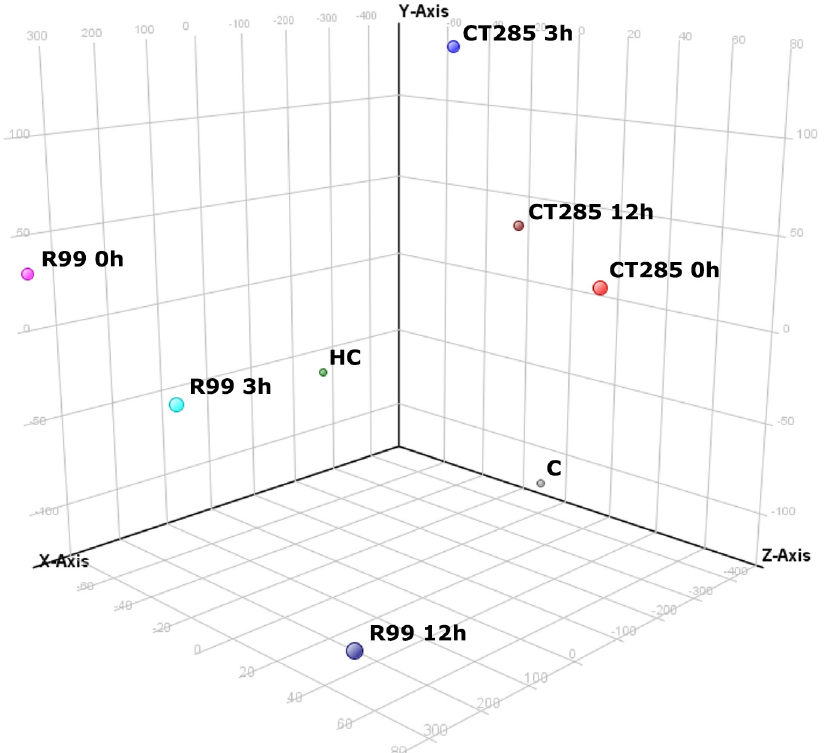
Fig 1. Principal Component Analysis (PCA) 3-D plot of the gills samples grouped by challenge. Three principal components are represented, PC1 on X-axis (54.78%), PC2 on Y-axis (14.53%) and PC3 on Z-axis (9.14%).